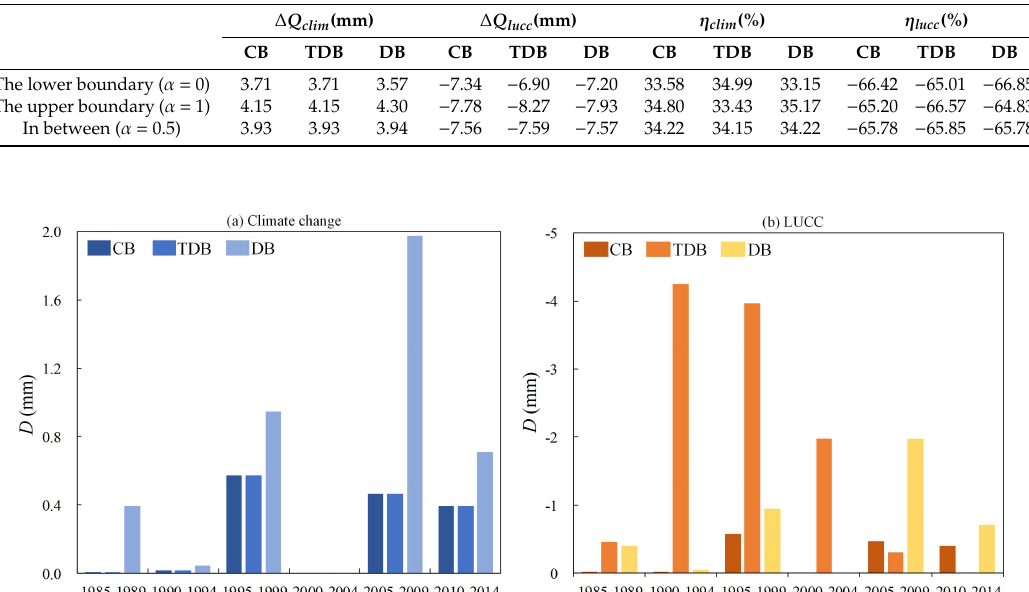
Figure 5. The di ff erences of ∆ Q clim in panel ( a ) and ∆ Q lucc in panel ( b ) between the cases of α = 0 and α = 1 using the three models of the CB, TDB, and present DB for six sub-variation periods. The di ff erences for the 2000–2004 period in panel ( a ) are less than 10 − 2 .